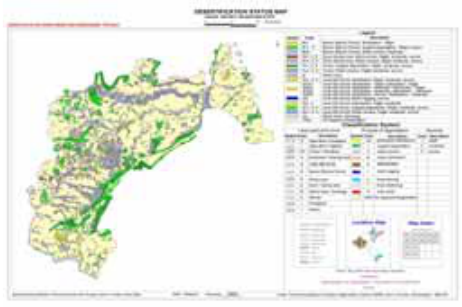
Fig. 1: DSM of Dausa district , Rajasthan